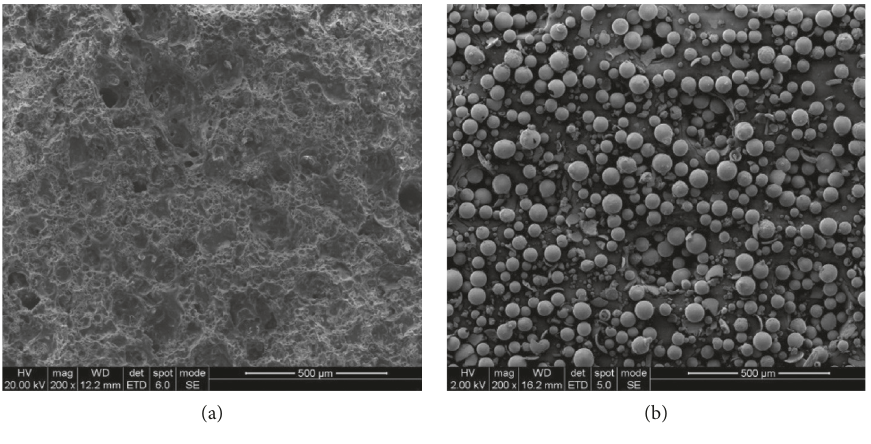
Figure 5: ESEM images of (a) SC and (b) FAC.